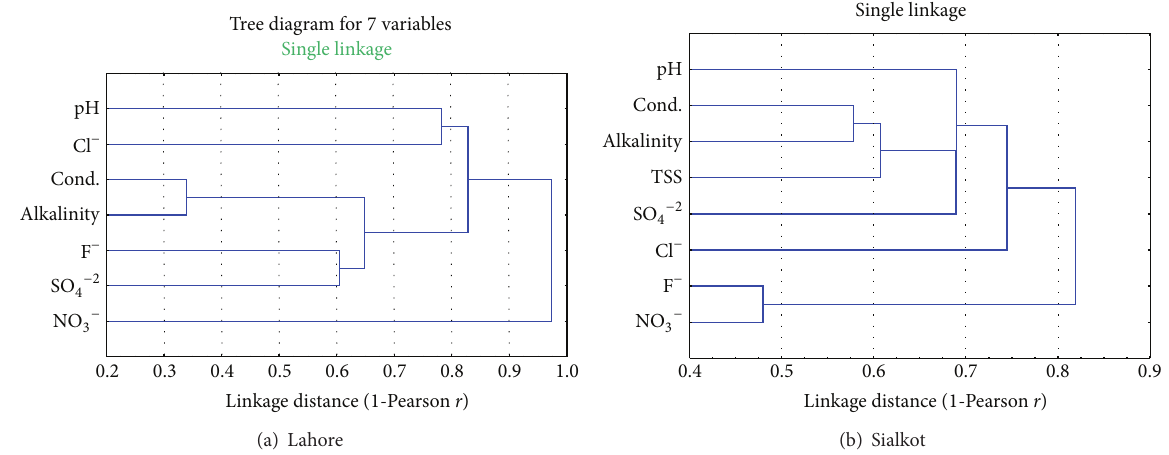
Figure 5: Cluster analysis for parameters from drinking water samples from Lahore and Sialkot.